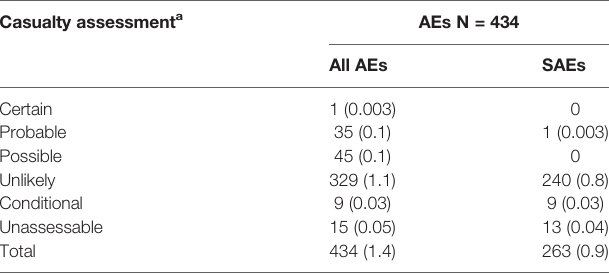
TABLE 2 | Casualty assessment of adverse events. Data are n